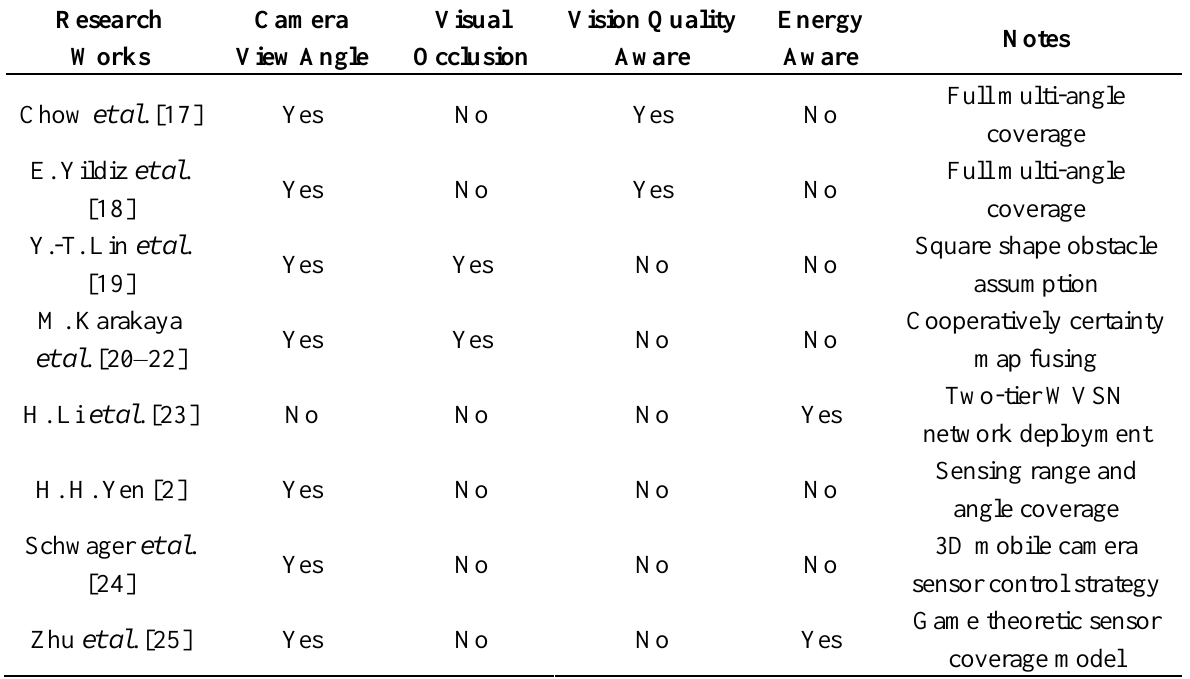
Table 2. Research works in WVSN